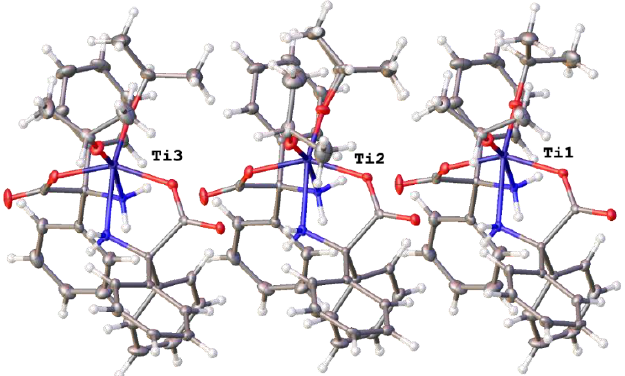
Figure 9. Asymmetric unit of 9 with atoms drawn as 50% probability ellipsoids. For clarity, some minor disorder is not shown. Selected bond lengths (Å ) and bond angles (°): Ti(1)-O(3) 1.7658(14),